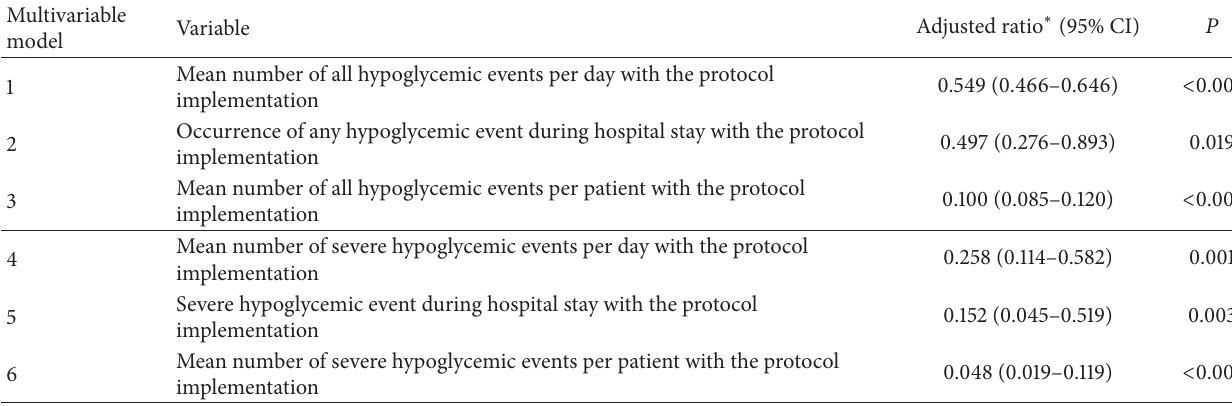
0.048 (0.019–0.119)